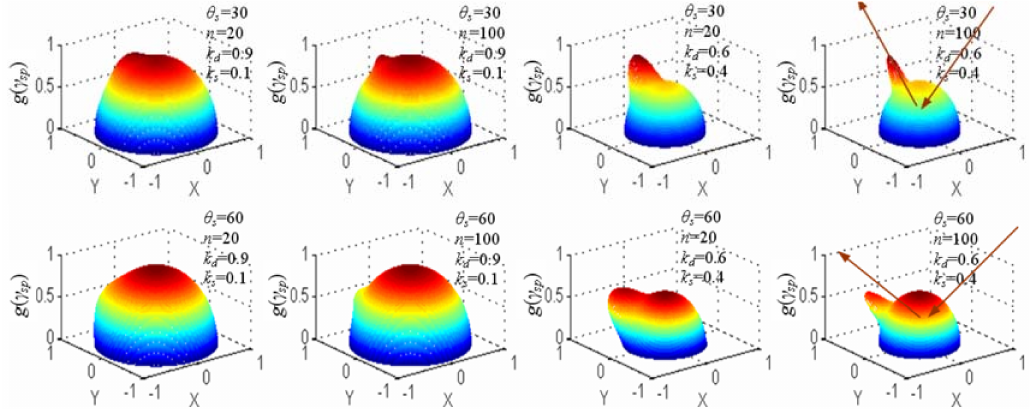
Figure 7. Function g ( θ s , θ v , ∆ ϕ ) with a Lambertian and a specular component of the reflectance of the environment for different values of θ s , k d , k s , and n